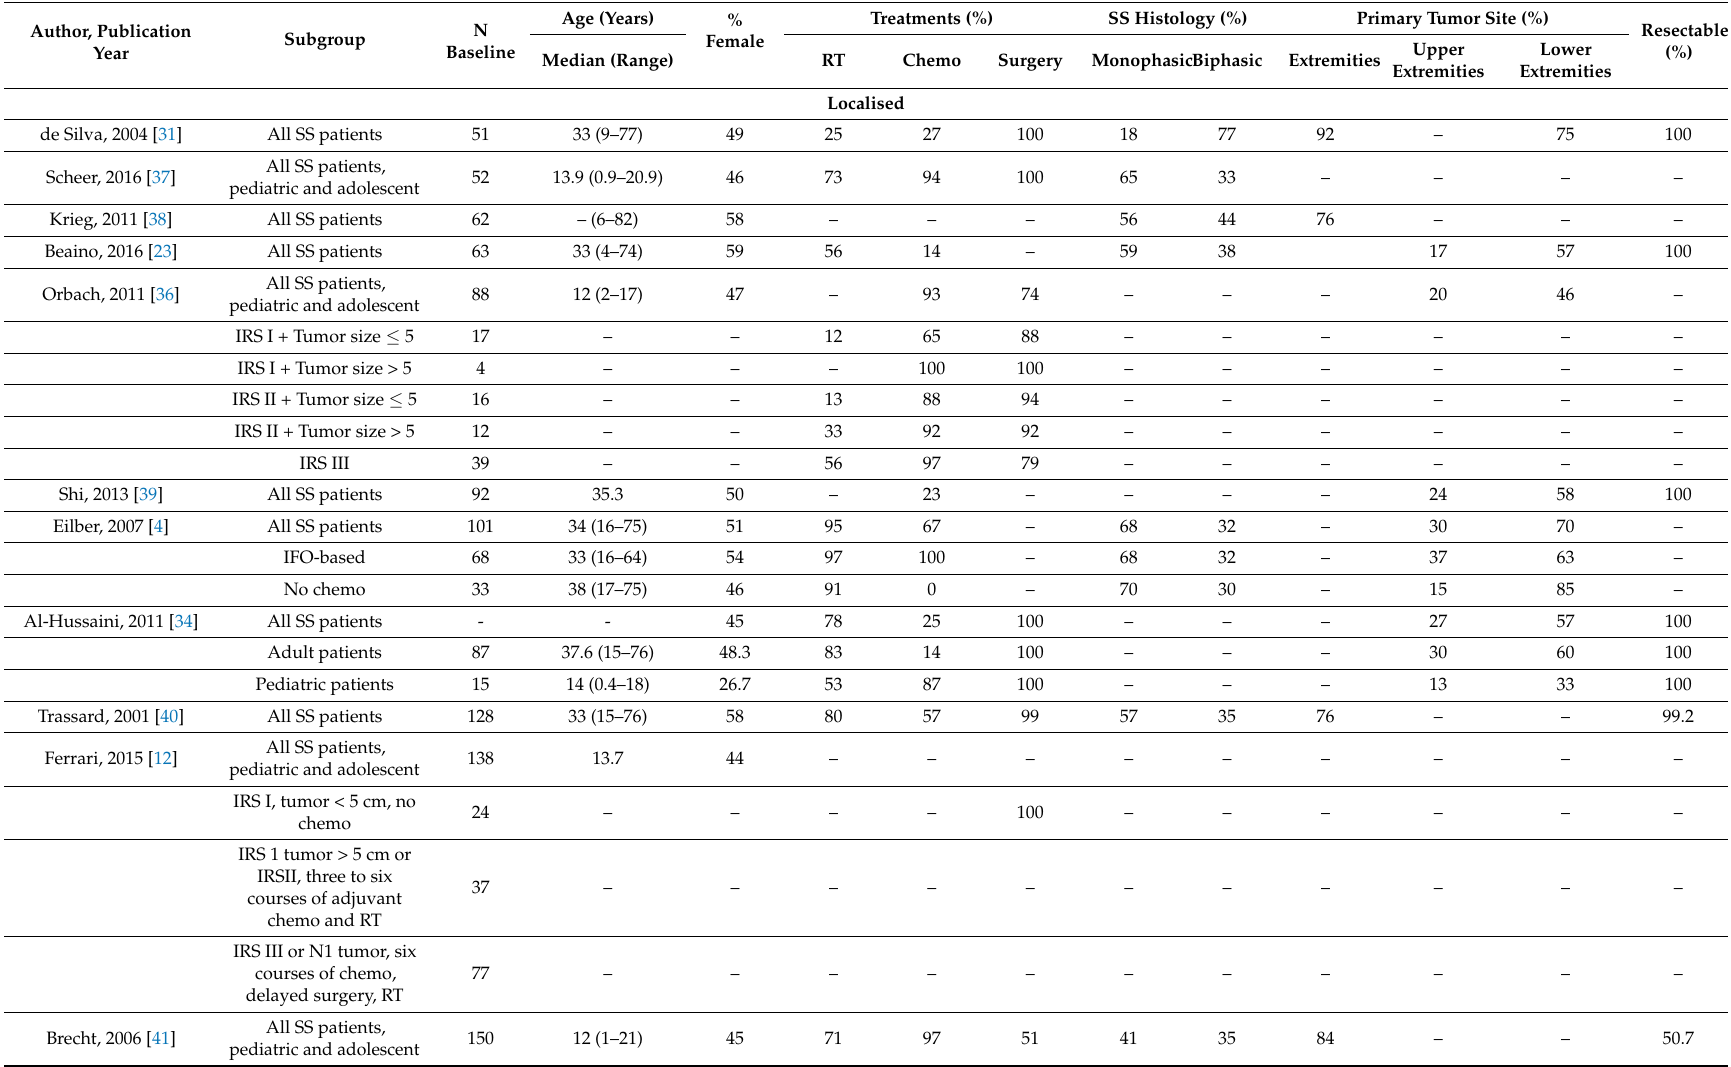
Table 3. Population